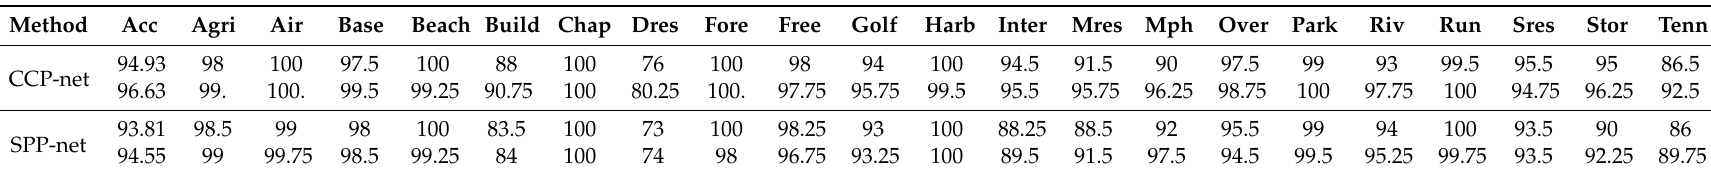
Table 3. The comparison of the CCP-net and SPP-net on the UC Merced and the rotated datasets. For each network, the two rows are the results of the UC Merced and the rotated datasets,